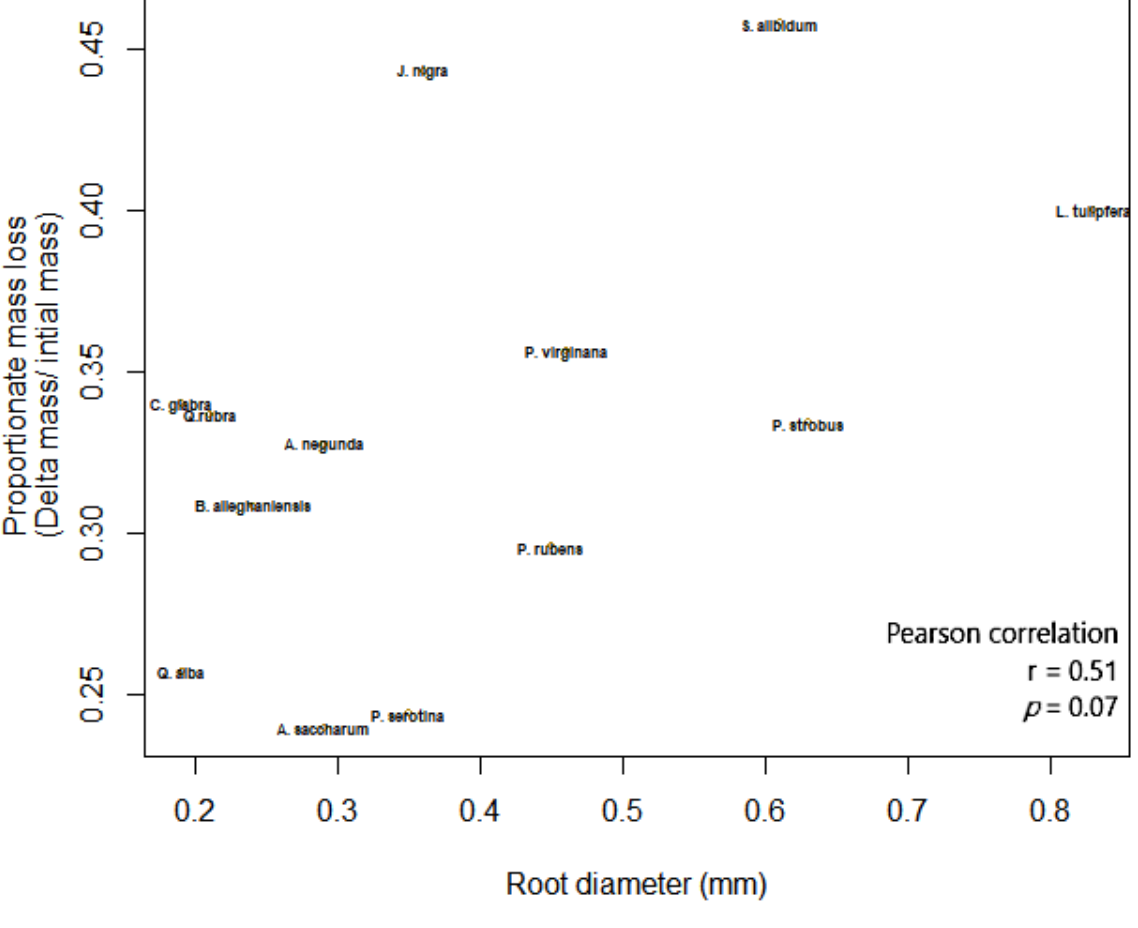
Figure 5. The association between root diameter (mm) and wood decomposition. Table 2. Four-way